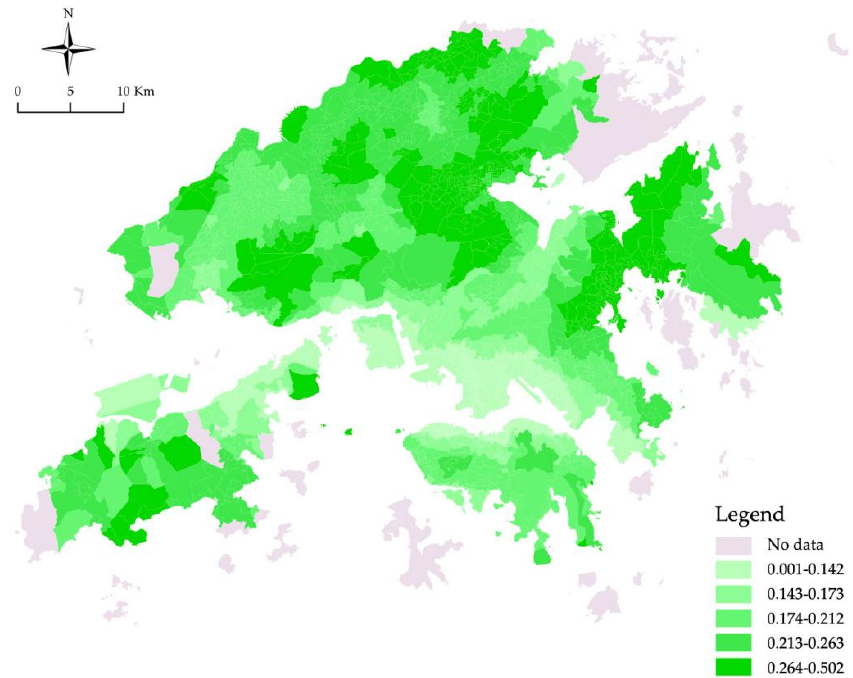
Figure 2. The geographical distribution of the green view index in Hong Kong.